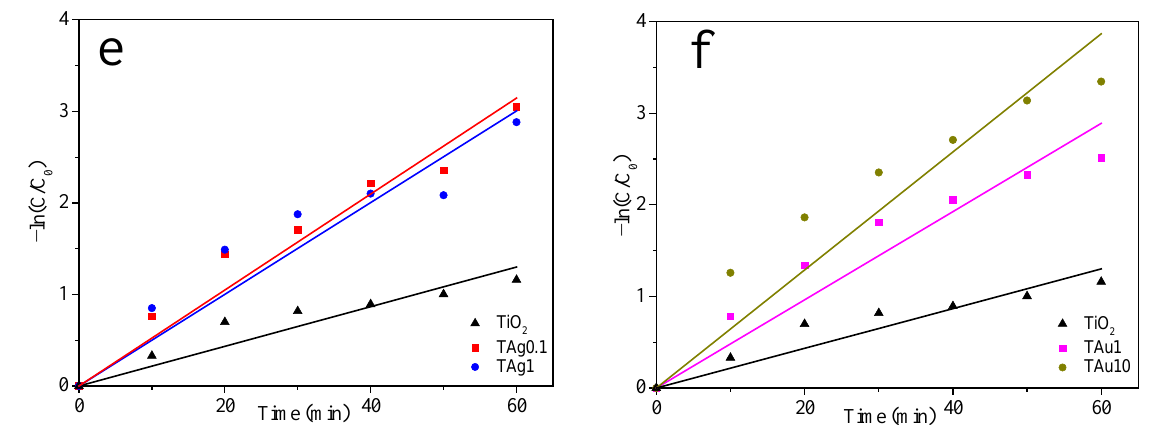
Figure 12. UV–Vis absorption spectra showing changes in the intensity of the MB dye under exposure to ultraviolet and visible-light: ( a ) TAg0.1; ( b ) TAu10. Variation of the photocatalytic degradation rate of MB dye on TiO 2 and decorated composites with time of irradiation ( c – d ). The pseudo first order kinetics of the degradation of MB dye on TiO 2 and deco- rated samples ( e – f